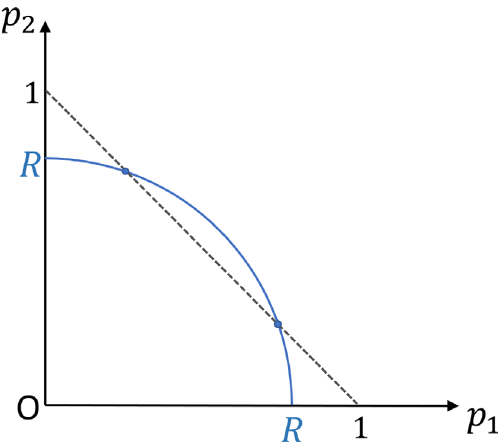
Figure 1. Schematic representation of the case n = 2. The total probability constraint (6) is represented by the dashed straight line, while the entropy constraint (7) is represented by the blue quarter circle of radius R . Solutions are given by their